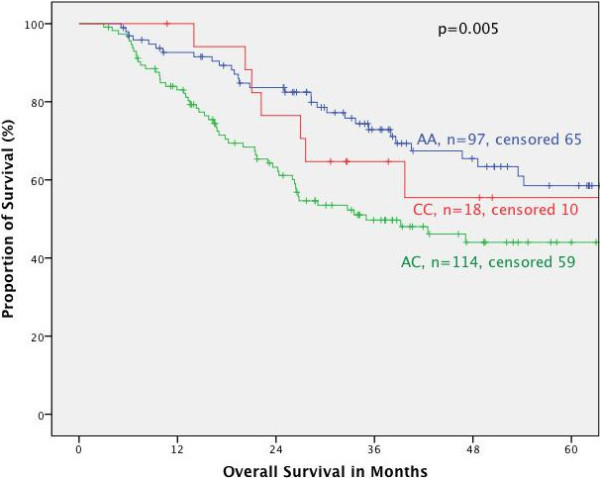
Survival in gastric cancer patients according to UICC 6th edition, MTHFR A1298C. Legend: Subgroup analysis for patients with adenocarcinoma of the esophagogastric junction type II, III and stomach dependent on polymorphisms of MTHFR A1298C. Median Survival times: AA 101.9 months, CC 74.2 months, AC 35.0 months, p = 0.005.